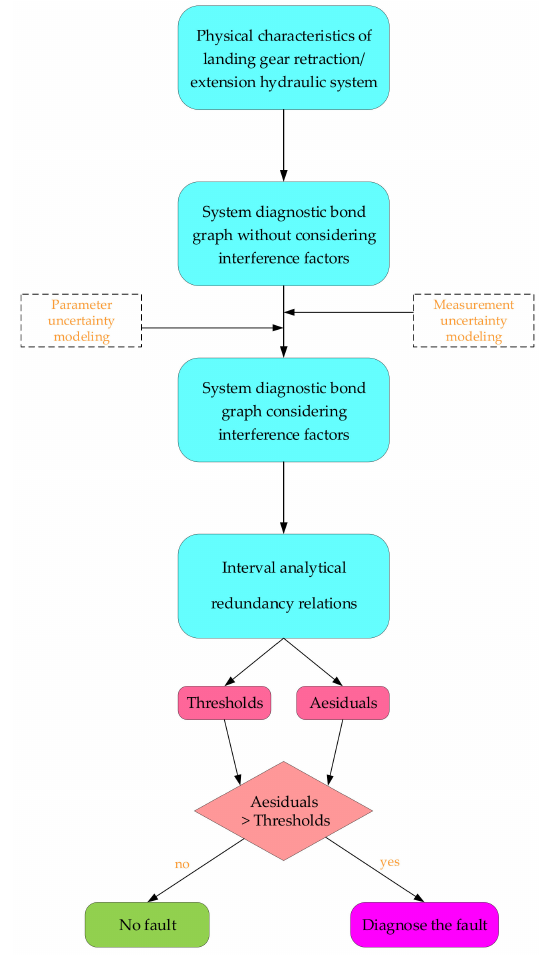
Figure 1. Analysis process and train of